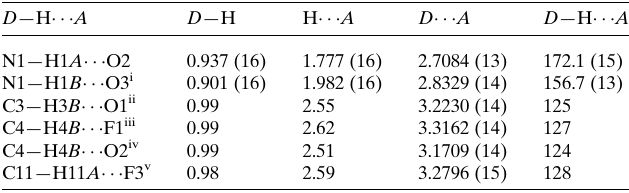
Table 2 Hydrogen-bond geometry (A˚ , (cid:5) ) for II .